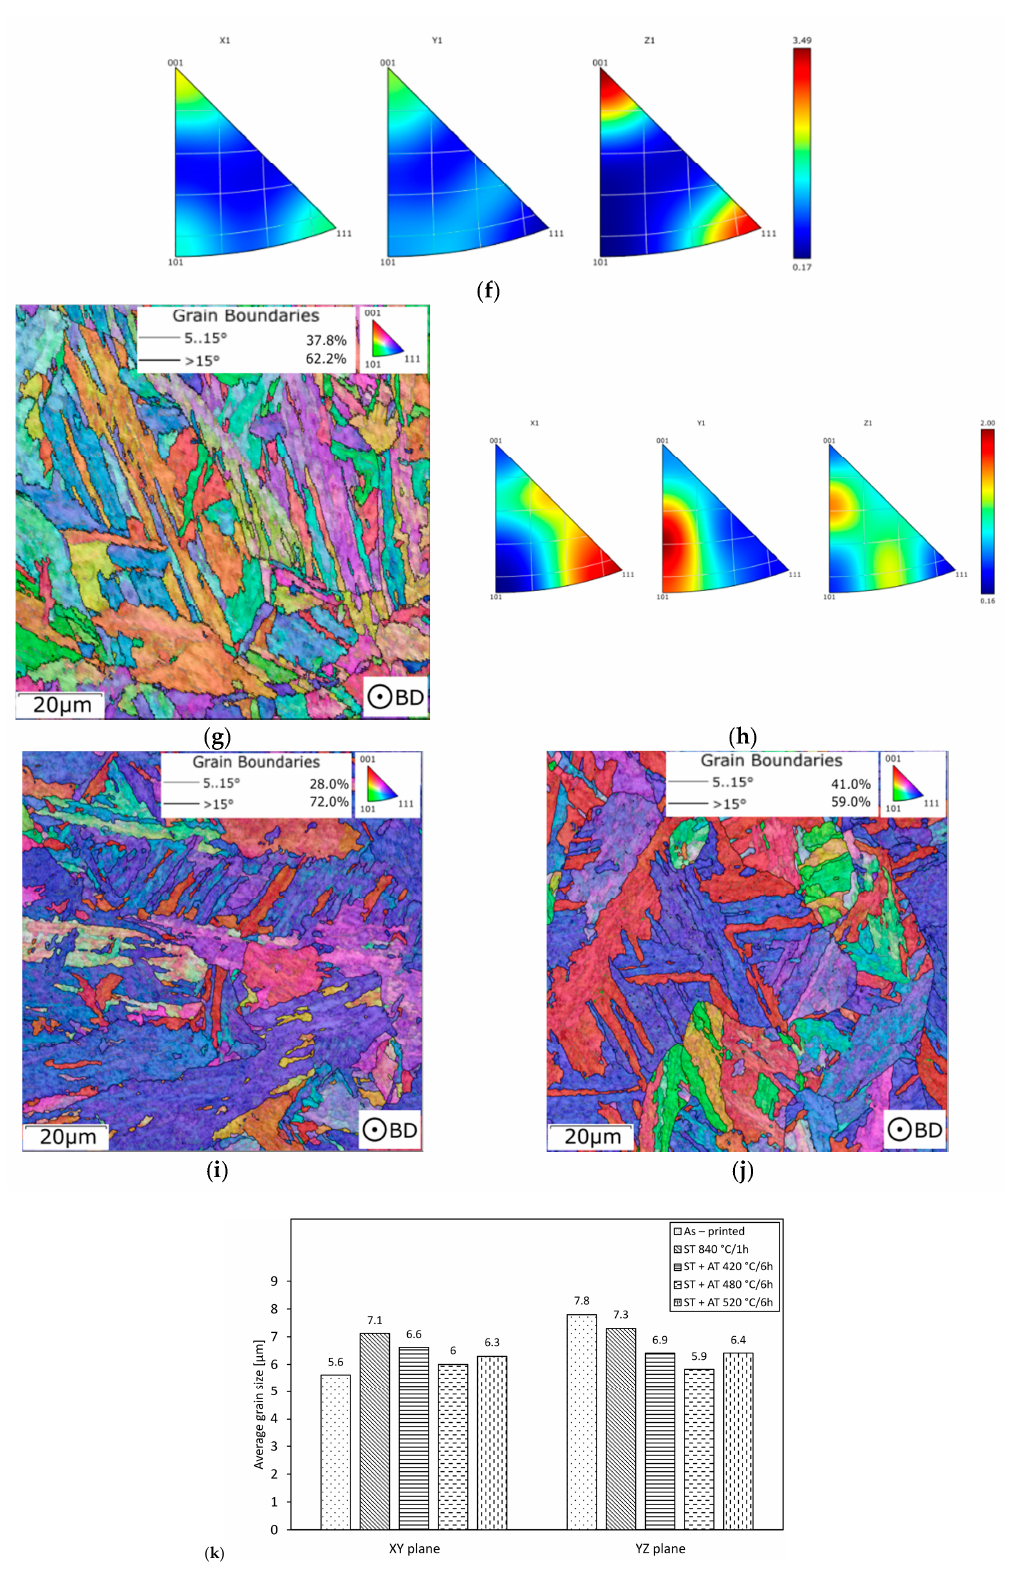
Figure 10. OIMs for sample 1 ( a ) XY plane and ( b ) YZ plane; sample after solution treatment ( c ) XY plane and ( d ) YZ plane. IPFs for sample 1, XY plane ( e ); sample after solution treatment, XY plane ( f ). OIM for sample 2, XY plane ( g ); IPFs for sample 2, XY plane ( h ). OIM for sample 5, XY plane ( i ); OIM for sample 7, XY plane ( j ); summary of average grain sizes in the XY and YZ planes ( k ).